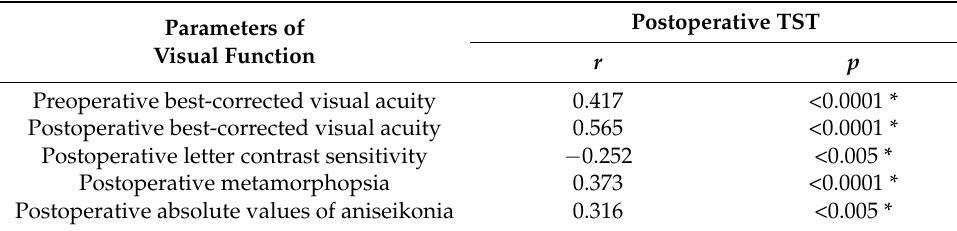
Table 2. Correlation between Titmus Stereo Test (TST) results and other visual functions after retinal detachment